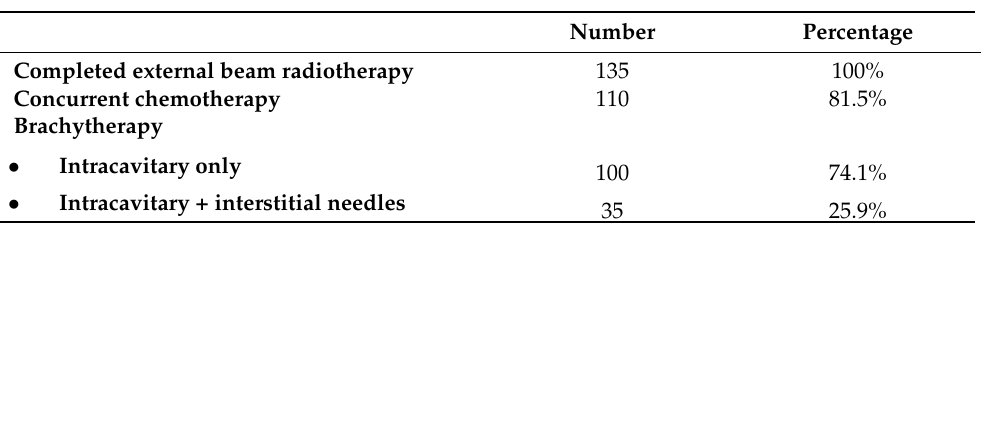
Table 2. Summary of brachytherapy